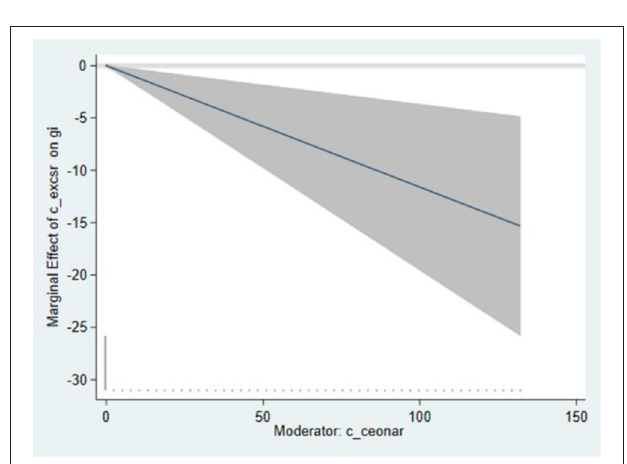
FIGURE 3 | Interaction between c_excsr and